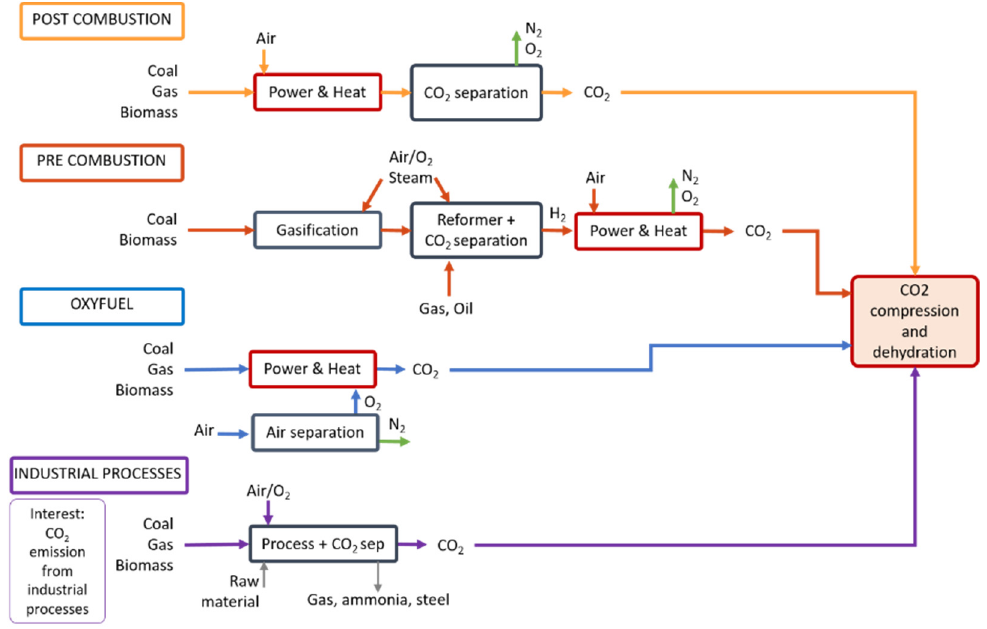
Figure 11. Flowchart of CO 2 capture processes and systems. Adapted from [127]. Table 9. Fundamental characteristics of carbon capture techniques.